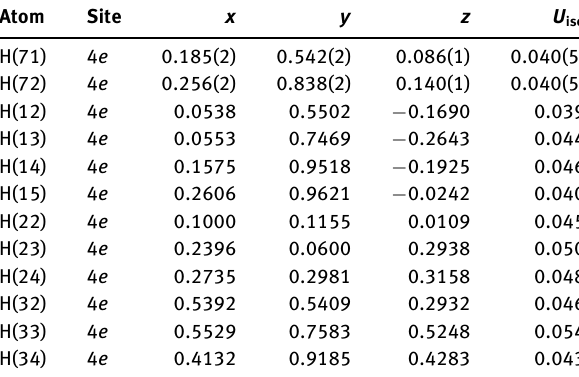
Table 2: Fractional atomic coordinates and isotropic or equivalent isotropic displacement parameters (Å 2